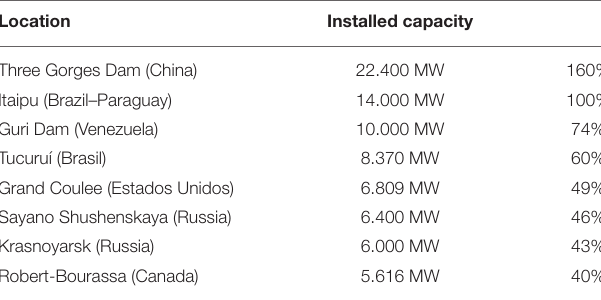
TABLE 3 | Installed capacity: comparison between the set of generating units of the main plants of the world.